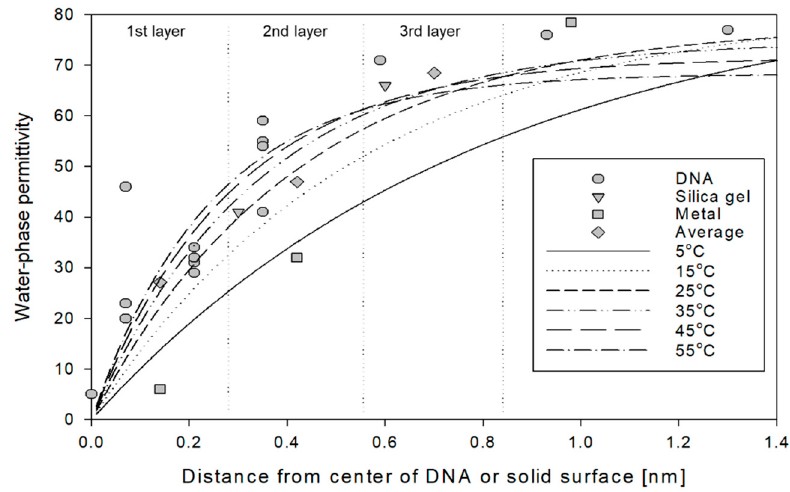
Figure 10. Measured and modeled water-phase permittivity as a function of distance from the center of DNA [162] or distance from the surface of silica gel [53] and metal [163] (digitized data). Computed temperature dependent permittivities based on free water permittivity and on bound water radius ( r = 2.5 × 10 − 10 ), specific surface area ( A s = 400 m 2 g − 1 ) and relaxation frequency ( f * = 1 GHz) from Equation (22).